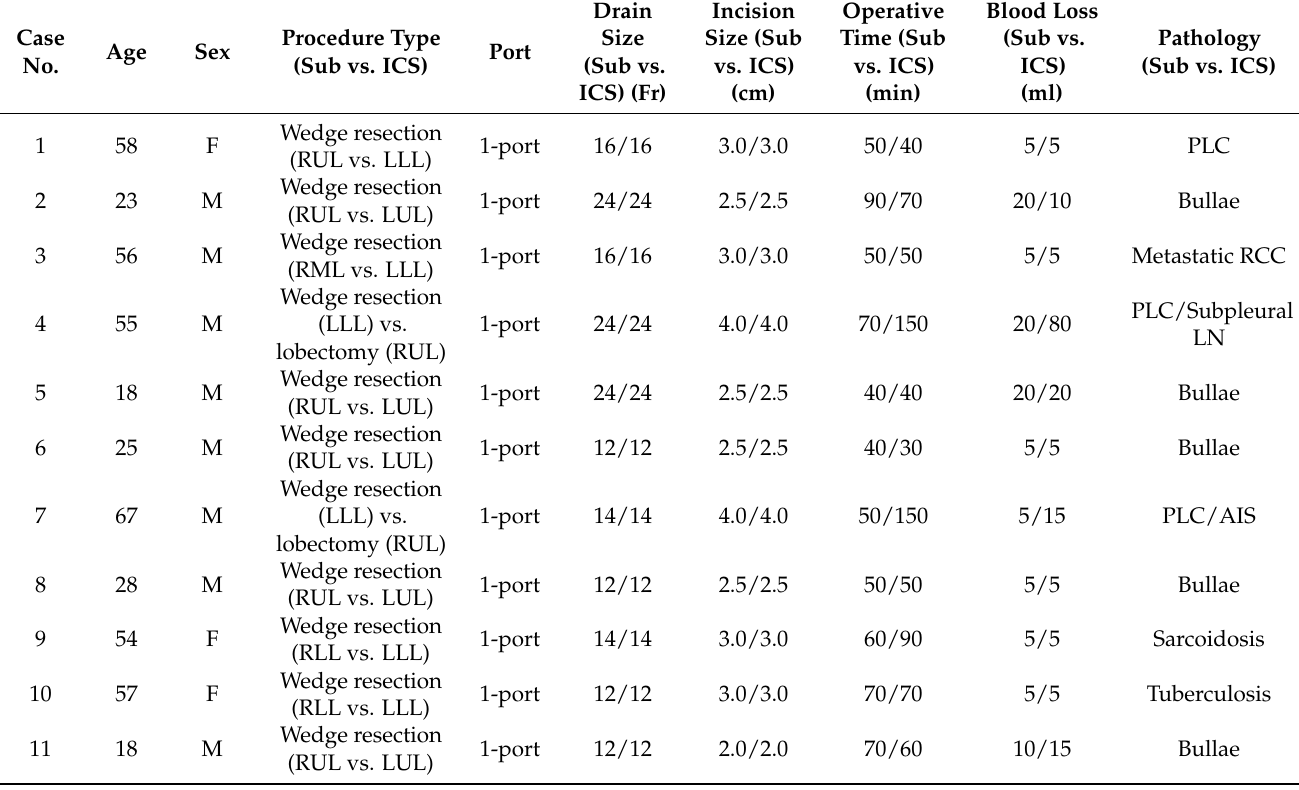
Table 1. Perioperative details of patients with bilateral VATS ( n =